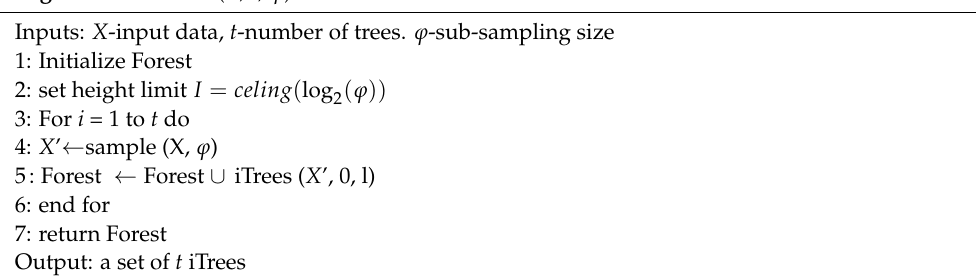
Algorithm 2 i Tree (X, e, l )